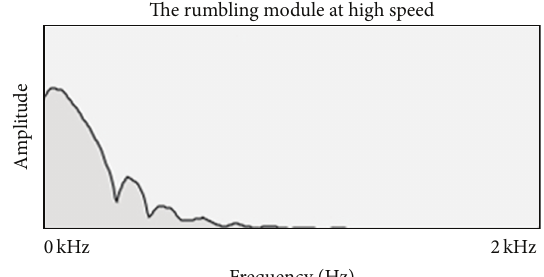
Figure 11: Spectrogram showing a snapshot of the random-noise bursts at high speed.